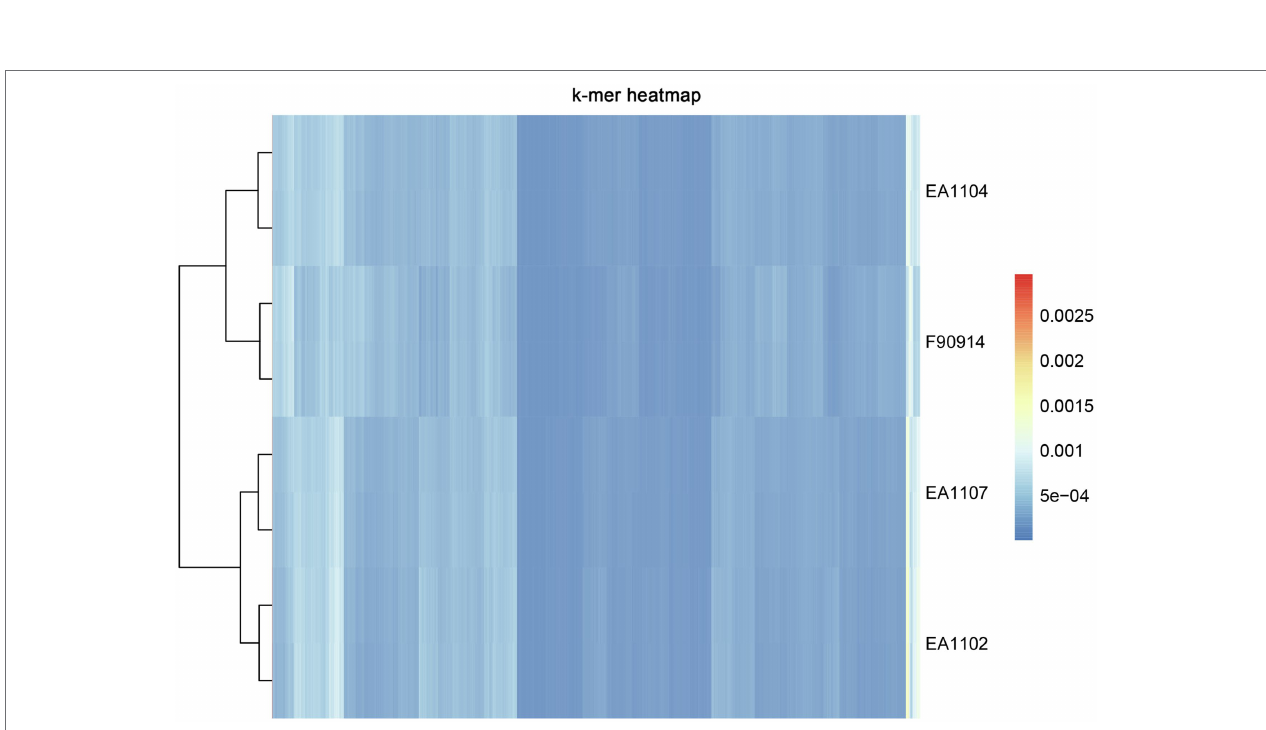
FIGURE 2 | Hierarchical clustering heat map of 6-mer analysis. Libraries were clustered by the frequency of 6-mer using the pheatmap package in the R software. K-mer analysis was processed by the Jellyfish program (Marcais and Kingsford,